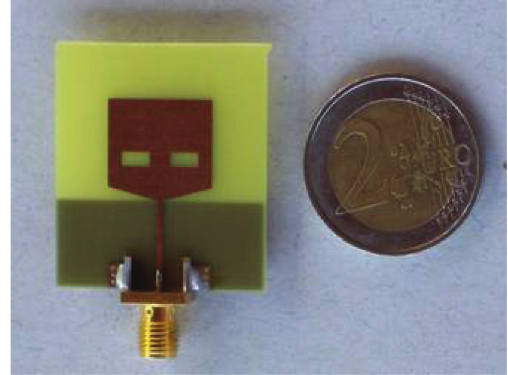
Figure 13: Prototype of UWB antenna realized.